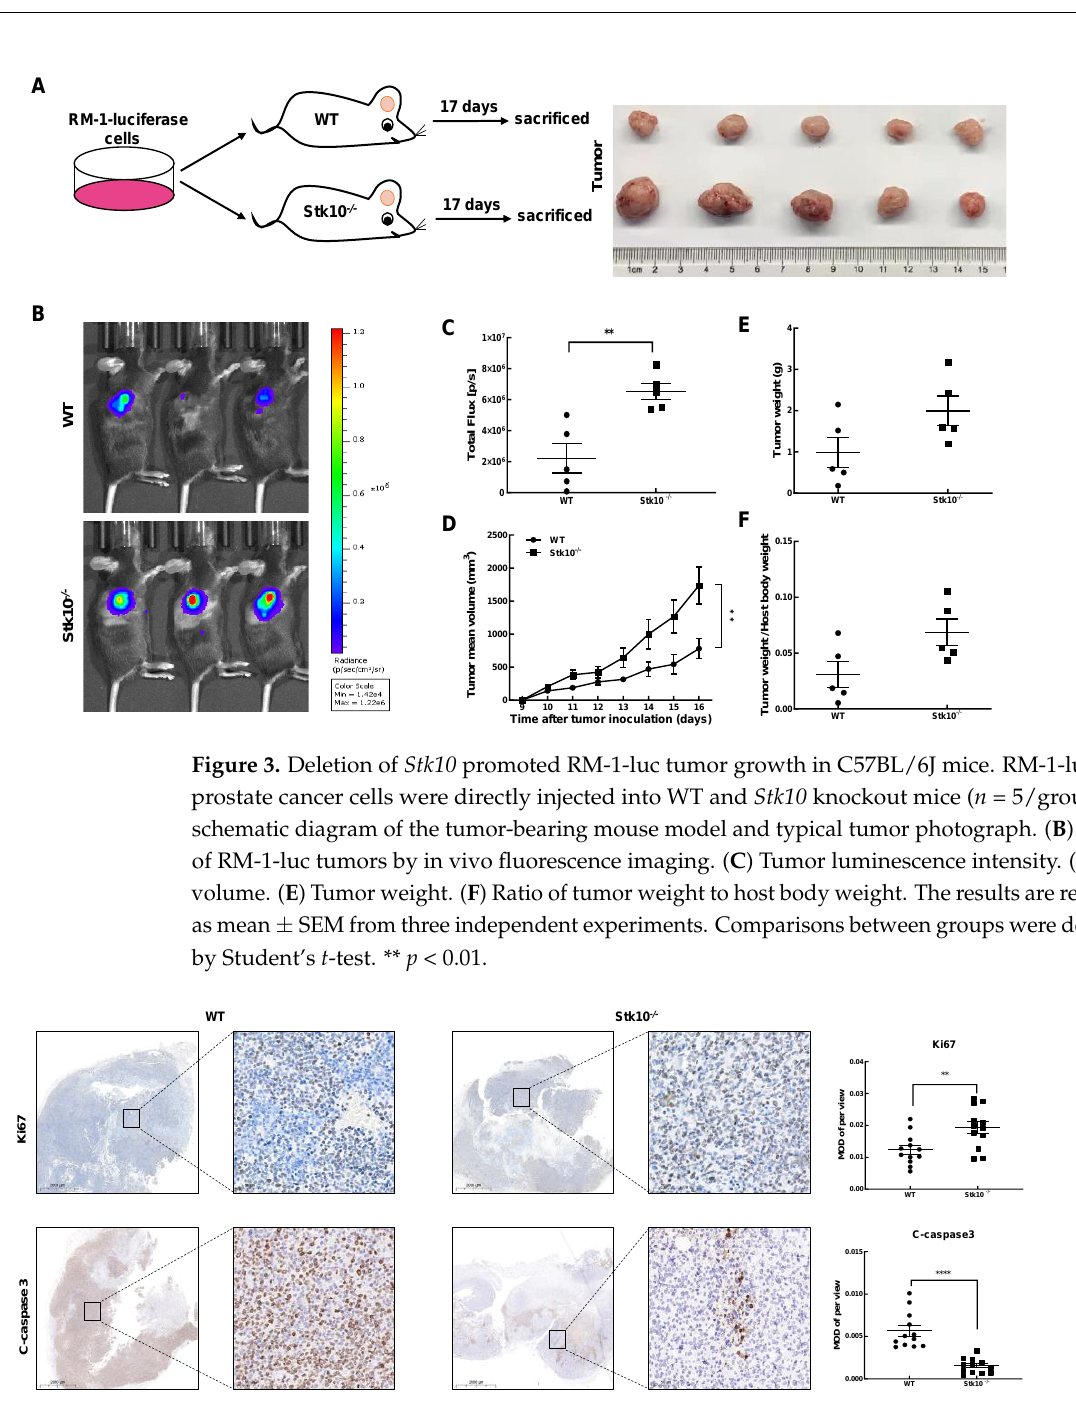
Figure 4. Stk10 deletion affected the proliferation and apoptosis of RM-1 tumor cells. Cell proliferation and apoptosis in the tumor tissue were analyzed by a immunohistochemistry assay for Ki67 and cleaved caspase-3, respectively ( n = 3/group). Scale bars: 2000 µ m ( left ) and 50 µ m ( right ). The average optical density after Ki67 and cleaved caspase-3 staining was measured with Image Pro Plus 6.0 software (Media Cybernetics, Inc.). Data represent the mean ± SEM. MOD: mean optical density. ** p < 0.01; **** p < 0.0001.